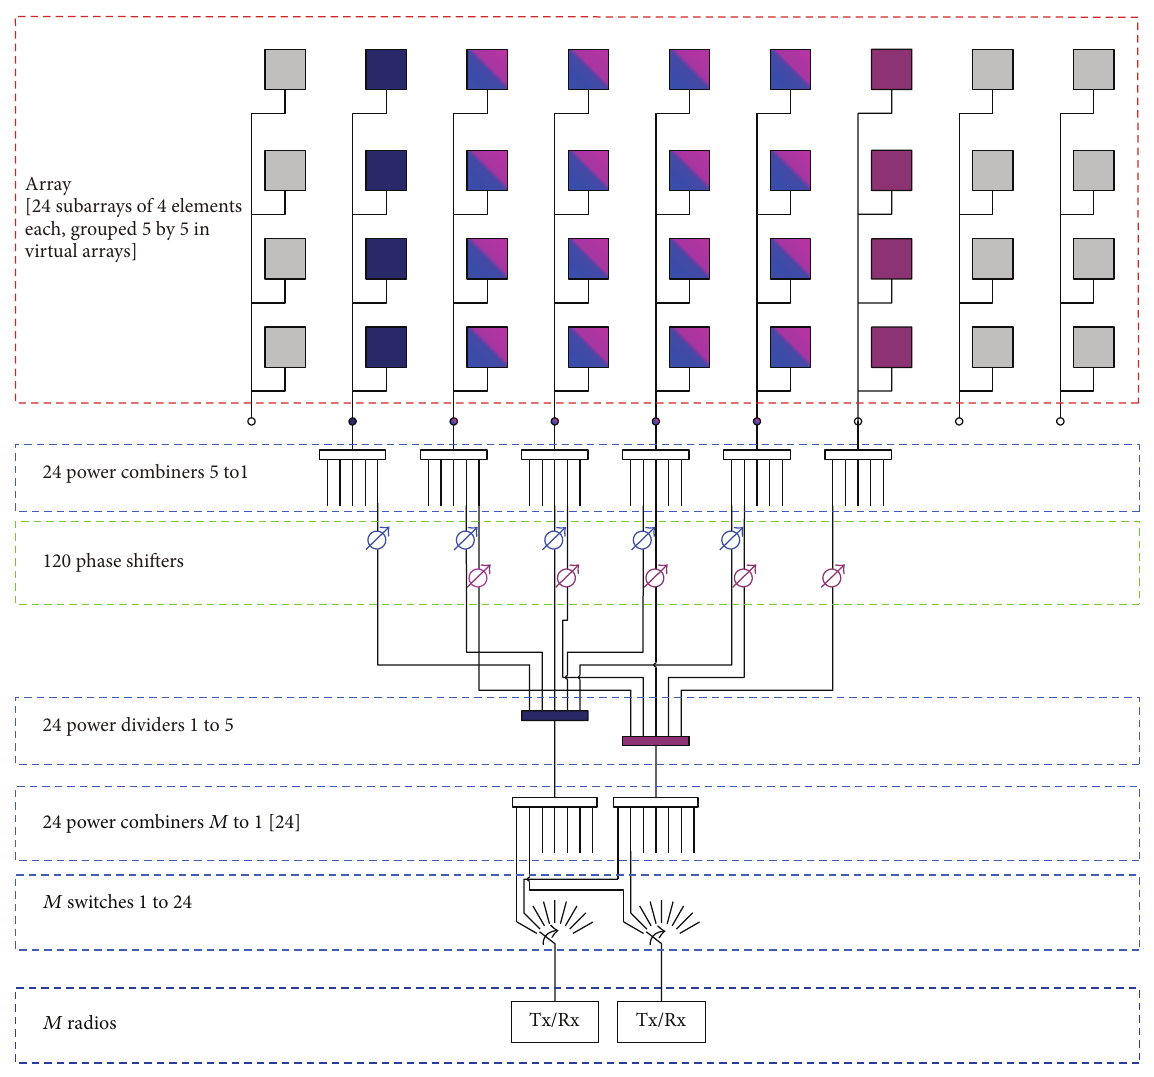
Figure 5: Smart antenna feeding network with beam synthesis capabilities.